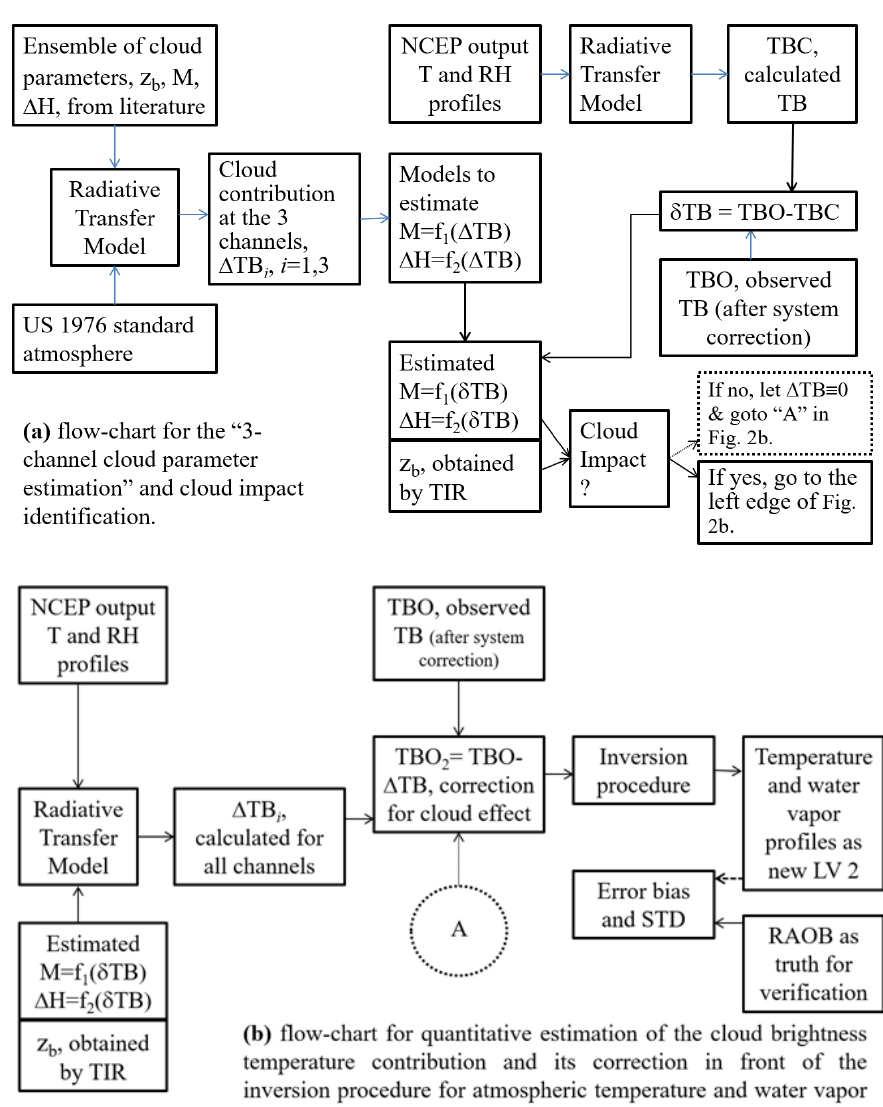
Figure 2. The technical flow chart for this study. ( a ) Flow-chart for the “3-channel cloud parameter estimation” and cloud impact identification. ( b ) Flow-chart for quantitative estimation of the cloud brightness temperature contribution and its correction in front of the inversion procedure for atmo- spheric temperature and water vapor density profiles. CI is equal or close to zero in the case when cloud impact can be neglected and TB correction for cloud is not necessary, as shown by the dotted box in Figure 2a, which leads a “goto” circled A shown in Figure 2b. It must be pointed that the cloud parameters obtained by the procedure above are only used as parameters required for the brightness temperature correction in the inversion calculation for cloudy atmospheric profiles. If one wants to apply them for other purposes, a proper validation may be needed though the model (Equation (12)) is based on 800 possible cloud parameter combinations (shown in Table